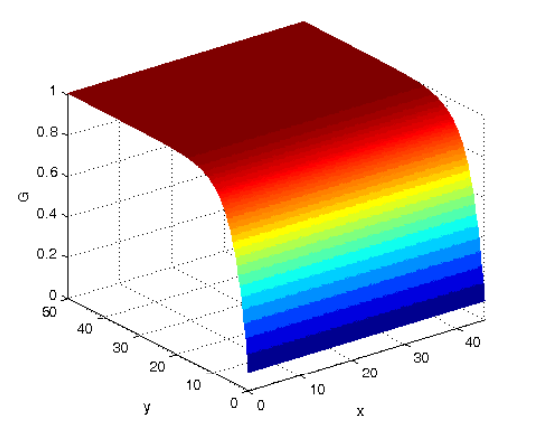
Figure 1. Numerical solution of kernel function G ( x , y )